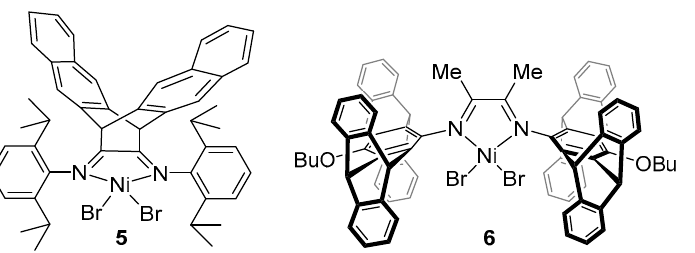
Figure 4. Dinaphthobarrelene backbone-based α -diimine nickel catalyst 5 and bispentiptycene- diimine nickel catalyst 6 .